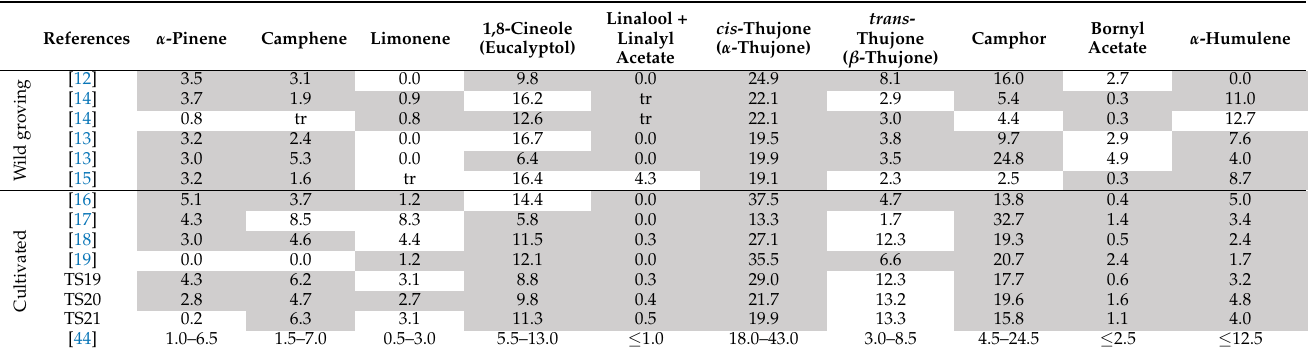
Table 4. Chemical composition of S. officinalis essential oil samples from Serbia and limited values according to ISO 9909